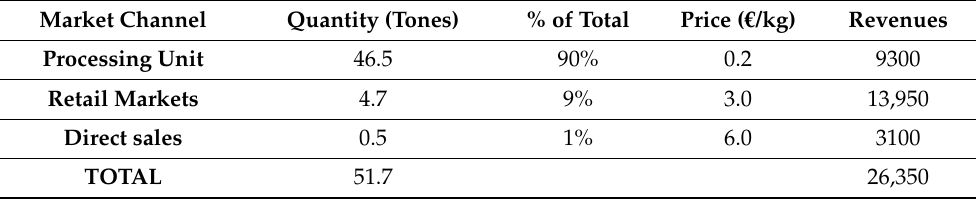
Table 4. Expected revenues from organic aloe vera leaves’ sales (per ha), based on the expected values of yields, market share and